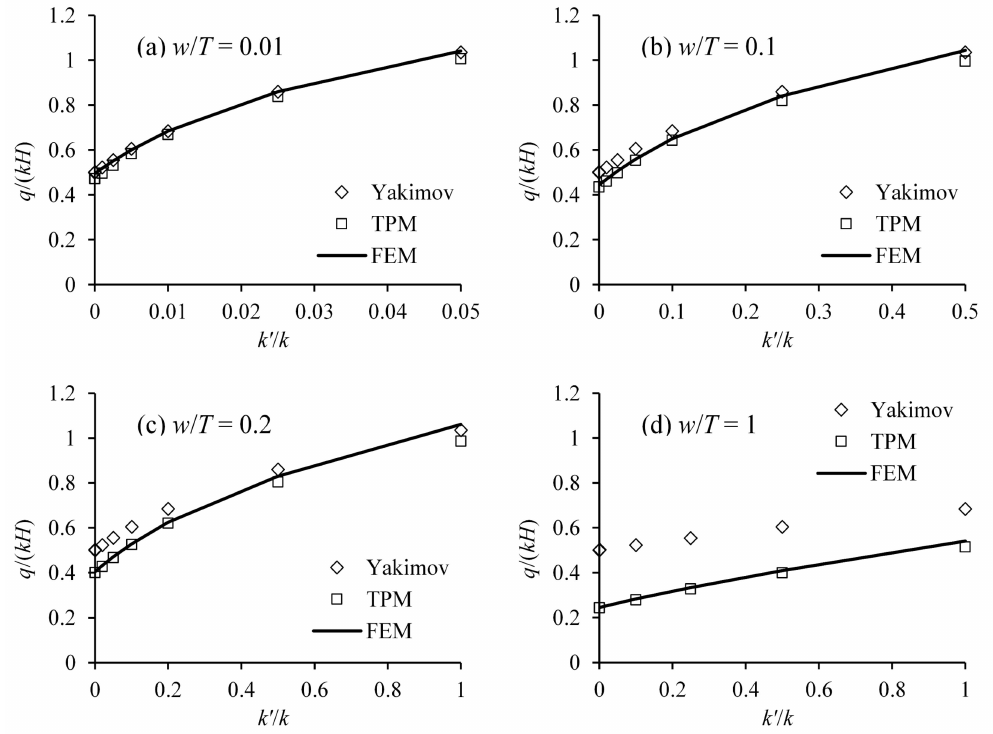
Figure 13. Comparisons of flow calculation results among Yakimov, TPM, and FEM for ( a ) w / T = 0.01, ( b ) w / T = 0.1, ( c ) w / T = 0.5, and ( d ) w / T =